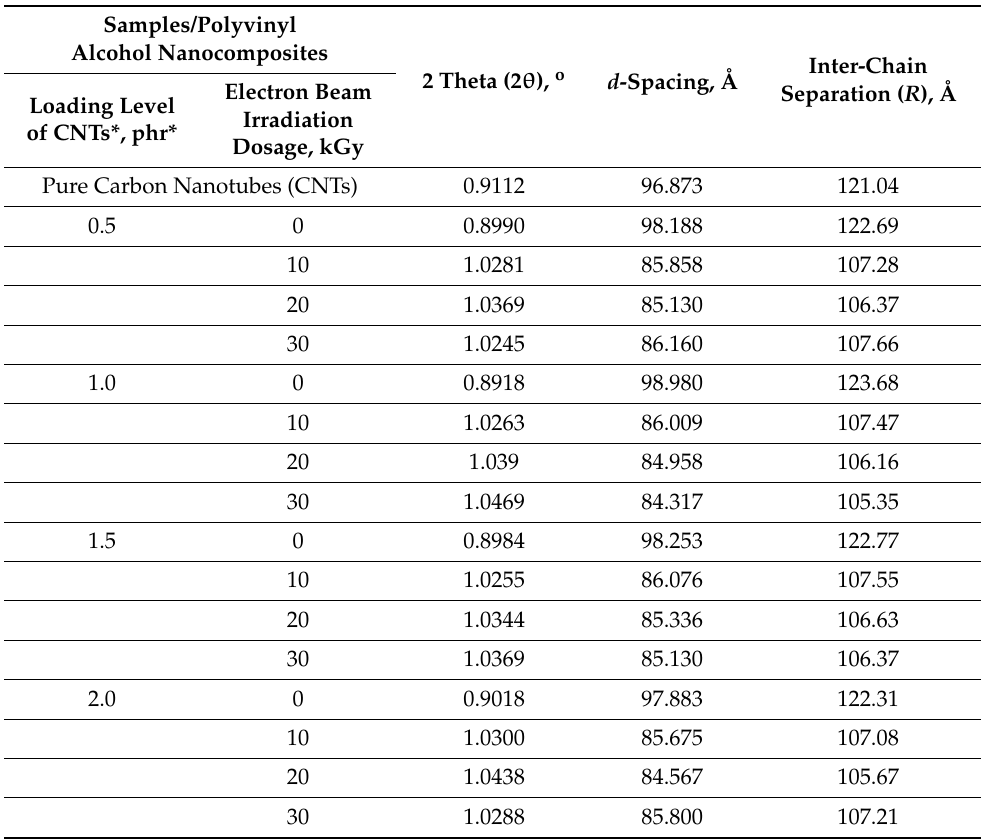
Table 1. Effects of increasing loading level of carbon nanotubes (CNTs) on the 2 theta (2 θ ), d -spacing, and interchain separation of deflection peak (002) on XRD curves for non-irradiated and irradiated polyvinyl alcohol (PVOH) nanocomposites, as depicted in Figure